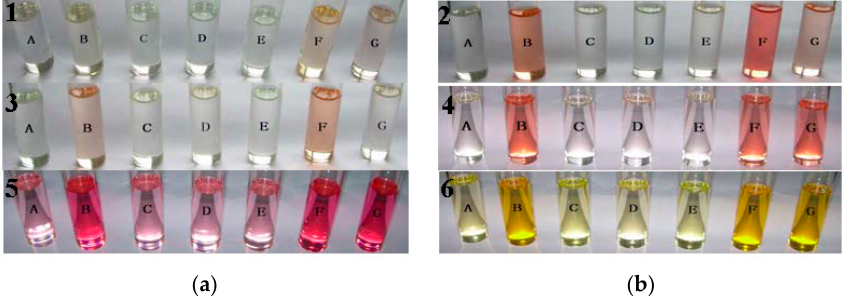
Figure 3. Color changes of six compounds with addition of various anions. ( A ) Blank; ( B ) F − ; ( C ) Cl − ; ( D ) Br − ; ( E ) I − ; ( F ) AcO − ; ( G ) H 2 PO 4 − . ( a ) Compound 1 , 3 and 5 ; ( b ) Compound 2 , 4 and 6 . ( D ) Br ´ ; ( E ) I ´ ; ( F ) AcO ´ ; ( G ) H 2 PO 4 ´ . ( a ) Compound 1 , 3 and 5 ; ( b ) Compound 2 , 4 and 6